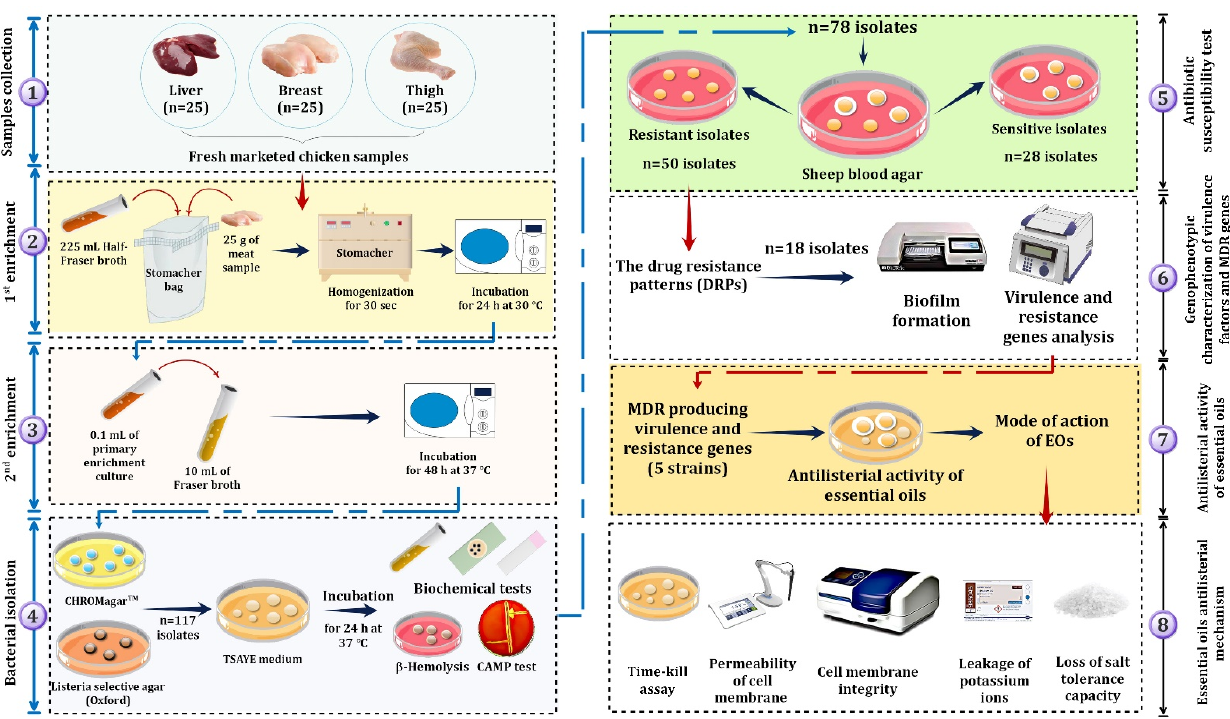
Figure 1. Schematic diagram of the experimental setup design for screening and characterizing L. monocytogenes isolated from fresh retail chicken meat samples.